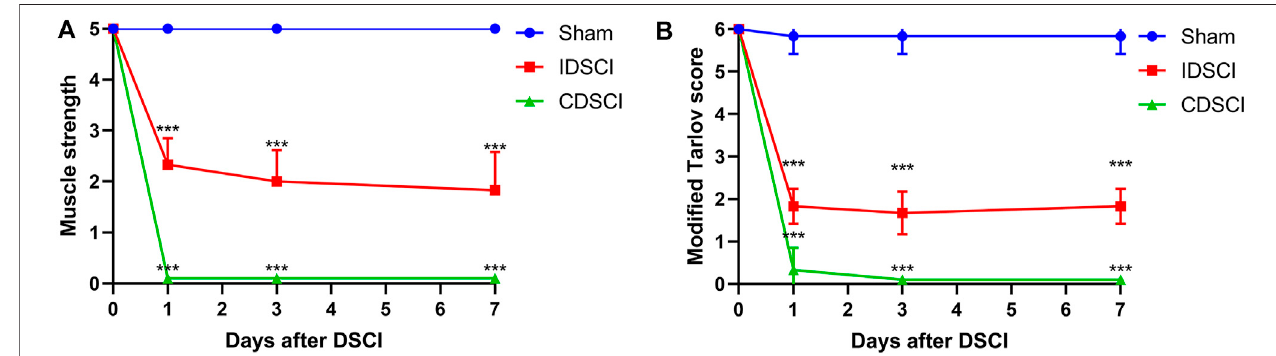
FIGURE2| TheneurologicfunctionchangesofhindlimbsfollowingDSCI. (A) Themusclestrengthofhindlimbsatthedifferenttimepointsinthesham,IDSCI,and CDSCI groups. (B) The modi fi ed Tarlov score of the hind limbs at the different time points in the sham, IDSCI, and CDSCI groups. All values are expressed as means ±